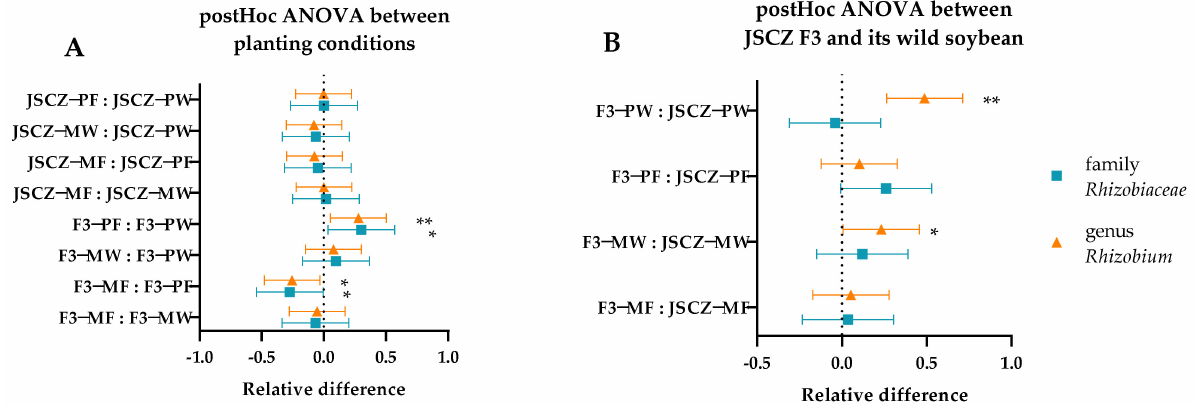
Figure 11. Post hoc of Rhizobiaceae and Rhizobium between JSCZ and F3. Note: ( A ) * and ** indicate significant difference ( p < 0.05) and extremely significant difference ( p < 0.01) of JSCZ F3 among the four planting conditions; ( B ) * and ** indicate significant difference ( p < 0.05) and extremely significant difference ( p < 0.01) between JSCZ F3 and its wild soybean. The positive and negative values of relative abundance reflect the relationship between the former and the